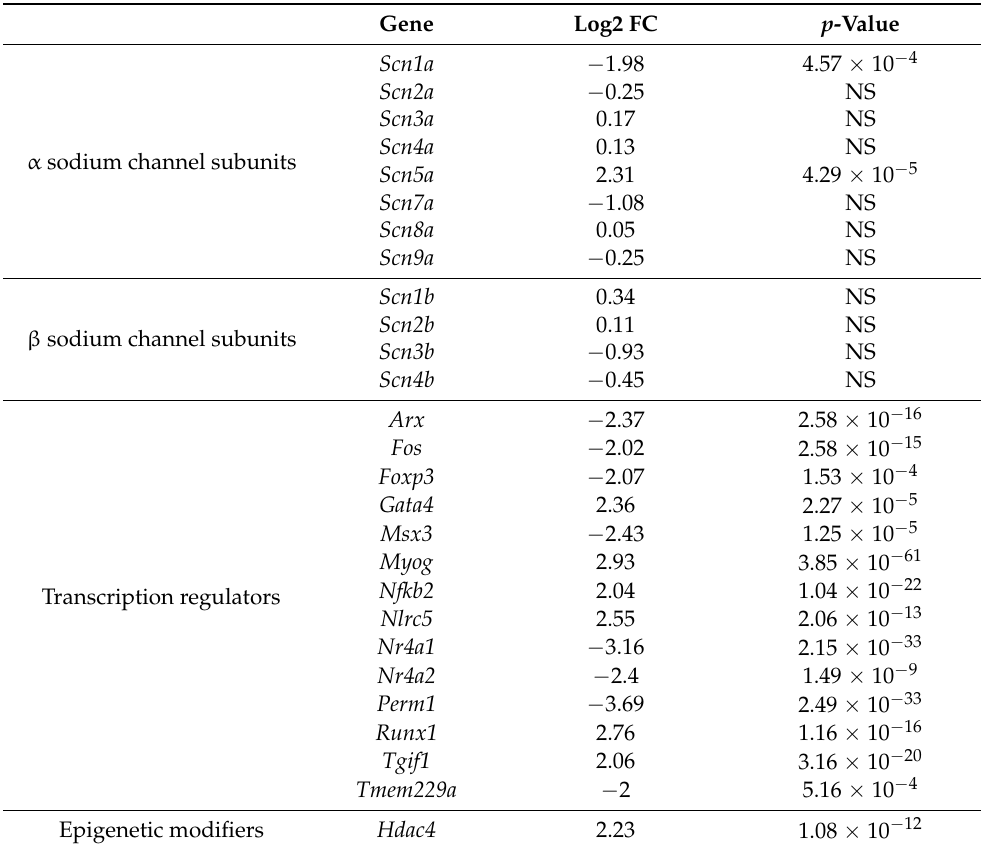
Table 1. Gene expression changes in denervated compared to control, innervated, muscle in the indicated categories. For each gene, the log2FC, and significance ( p -value) are indicated. Gene Log2 FC p -Value